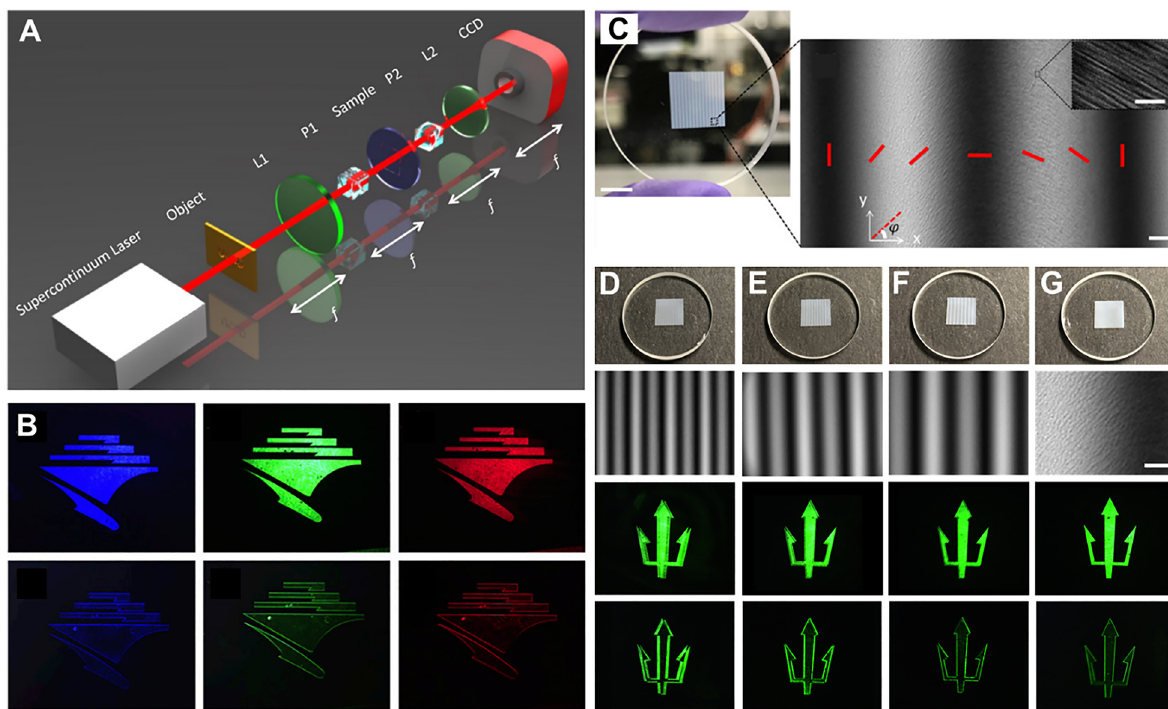
Figure 7: Broadband edge detection based on high-efficiency PB phase metasurface [96]. (A) Experimental setup: two lenses form a 4f system, and the metasurface (sample) is placed between P1 and P2. L: lens, P: polarizer. (B) The metasurfaceperiod Λ oftheimagingexperimentis8000 μ m.Theilluminationwavelengthsarerespectively430,500and670nm.The fi rstrow shows the images without the analyzer after the sample, and the second row shows the edge image with the crossed polarizers. (C) Photograph of a sample with a diameter of 2.54 cm (left), with a metasurface pattern area of 8 × 8 mm (scale bar: 5 mm). The optical image of themarkedsample(right),theredlinesindicatethedirectionofthenanostructureinaperiod.TheinsetistheSEMimageofthenanostructure (scale bar: 500 nm). (D) – (G) Various resolutions of edge detection with different phase gradient periods: 500, 750, 1000, and 8000 μ m, at the wavelength of 500 nm. The fi rst row is photographs of different metasurface samples. The second row is polarized images of the samples (scale bar, 125 μ m). The third row is two separated LCP and RCP images without the analyzer. The fourth row is edge images corresponding to different